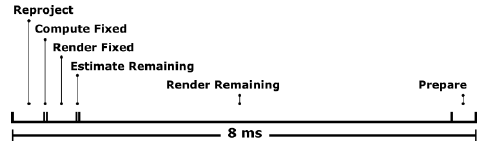
Figure 1. The adaptive fill budget renders a fixed amount of points first, and then an estimated additional amount that can be rendered in the remaining time of the